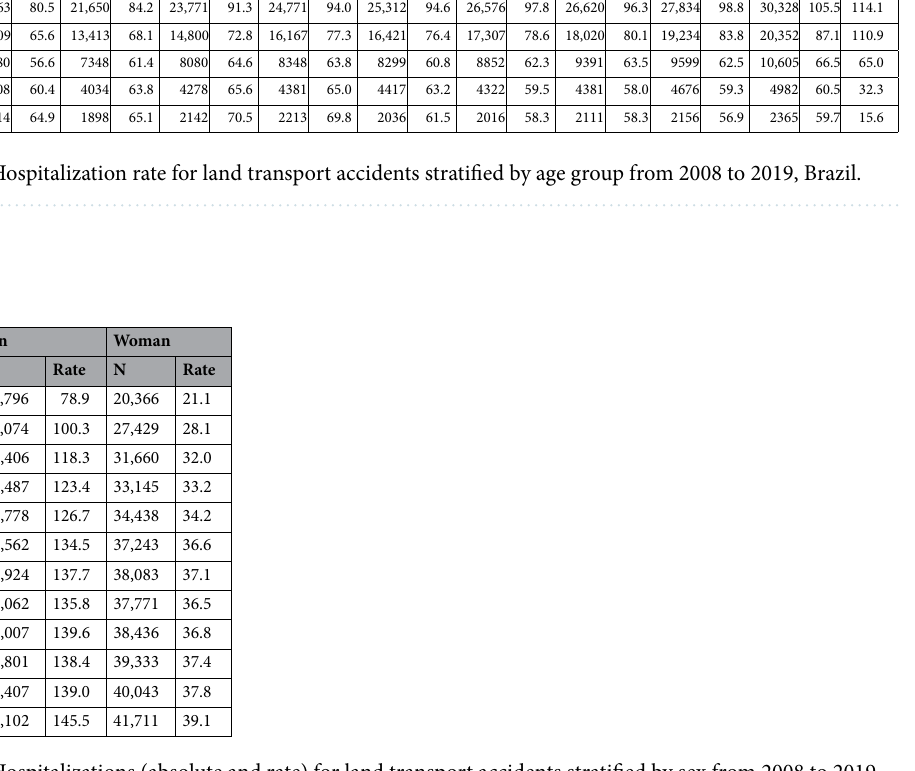
Table 3. Hospitalizations (absolute and rate) for land transport accidents stratified by sex from 2008 to 2019, Brazil.